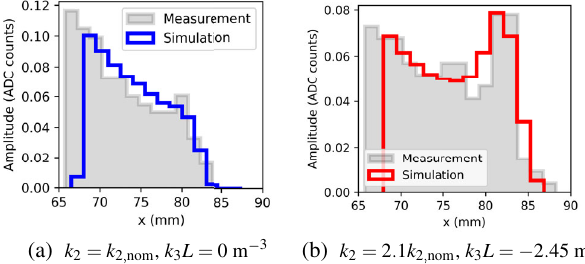
FIG. 18. Horizontal beam profile at BSGH.216 upstream ZS.